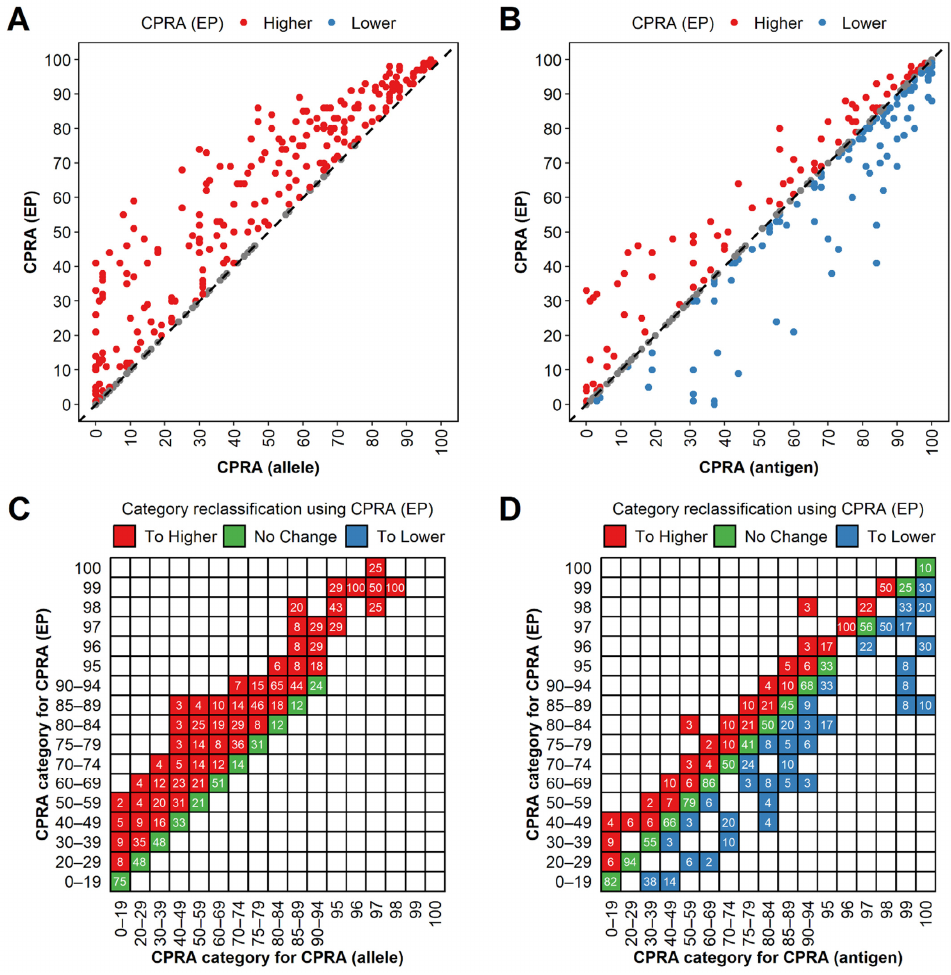
Figure 4. Comparison of calculated panel-reactive antibody (CPRA) values calculated at eplet-predicted level [CPRA (EP)] to those at the HLA allele level [CPRA (allele)] and HLA antigen level [CPRA (antigen)]. ( A ) CPRA (EP) values were higher than CPRA (allele) values for 340 cases (red) and equal for the rest of the cases (grey). ( B ) CPRA (EP) values were higher than CPRA (antigen) values for 121 cases (red) and lower for 170 cases (blue). Reclassification of CPRA categories from CPRA (allele) ( C ) and CPRA (antigen) ( D ) to CPRA (EP). Each case was assigned a primary CPRA category based on the CPRA (allele) or CPRA (antigen) (x-axis) and a secondary CPRA category based on the CPRA (EP) (y-axis). Labels indicate the percentage of cases within the CPRA (allele) or CPRA (antigen) category that moved to different categories using CPRA (EP). Candidates who did not change, moved to higher, or moved to lower categories were colored green, red, or blue, respectively.